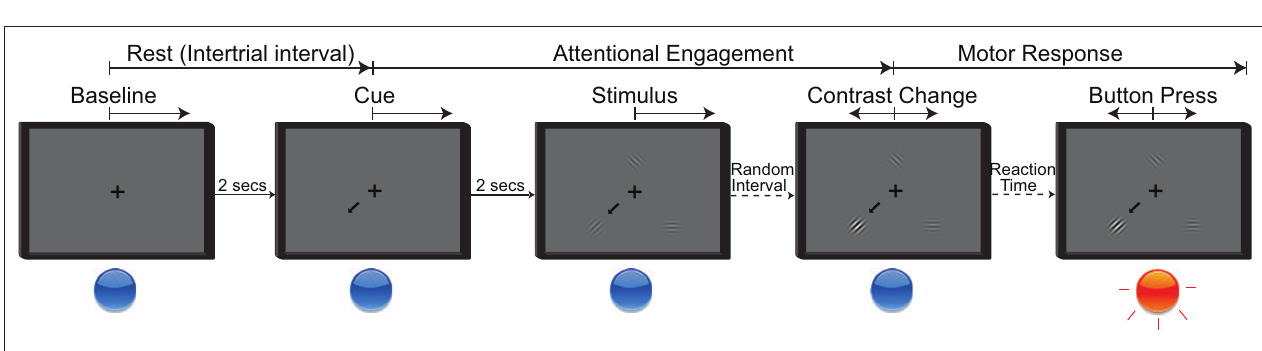
Contrast change: Cued stimulus changes contrast; Button press: Subjects acknowledge the contrast change by pressing the button as quickly as possible.